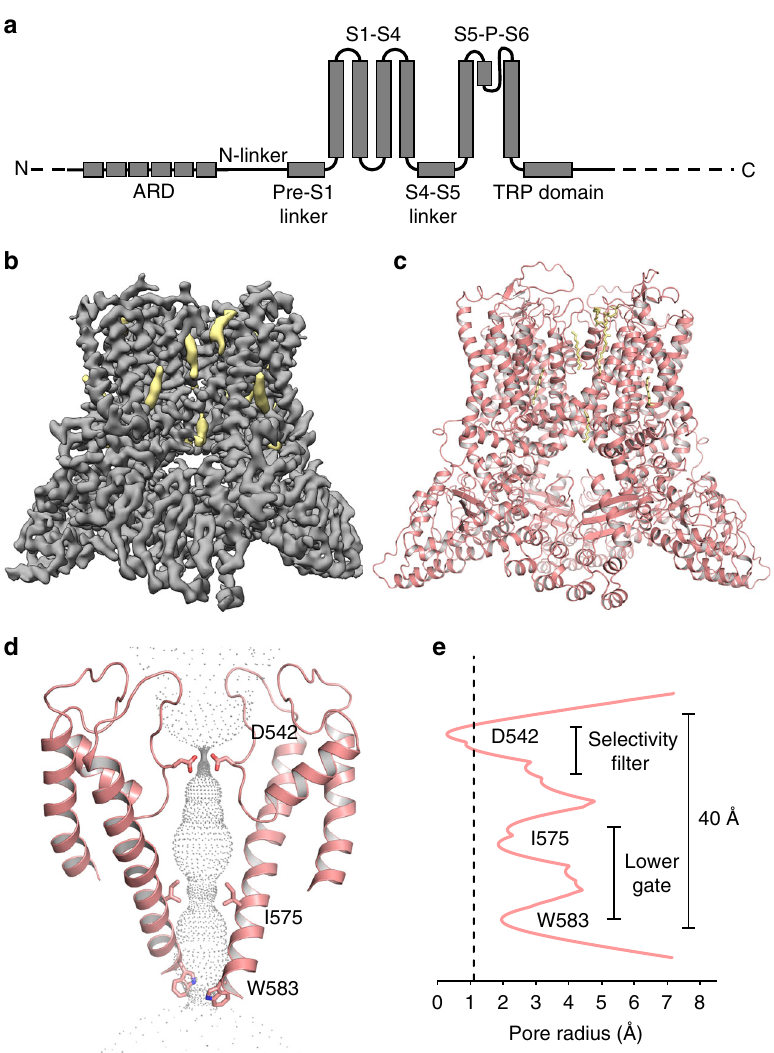
Fig. 1 Lipid-bound TRPV5 structure in detergent. a A schematic representation of the TRPV5 domains per channel monomer. Dashed lines indicate regions for which a model could not be built. b Density map of lipid-bound TRPV5 at 3.9 Å resolution. Density for TRPV5 is shown in gray and the densities attributed to annular lipids are shown in khaki. c Cartoon representation of the lipid-bound TRPV5 model. The TRPV5 tetramer is depicted as pink cartoons and annular lipids as khaki sticks. d Cartoon representation of the lipid-bound TRPV5 pore highlighting the three constriction points in the selectivity fi lter and lower gate. e Plot of pore radii of lipid-bound TRPV5 as a function of distance through the pore. The dotted line indicates the radius of a dehydrated calcium